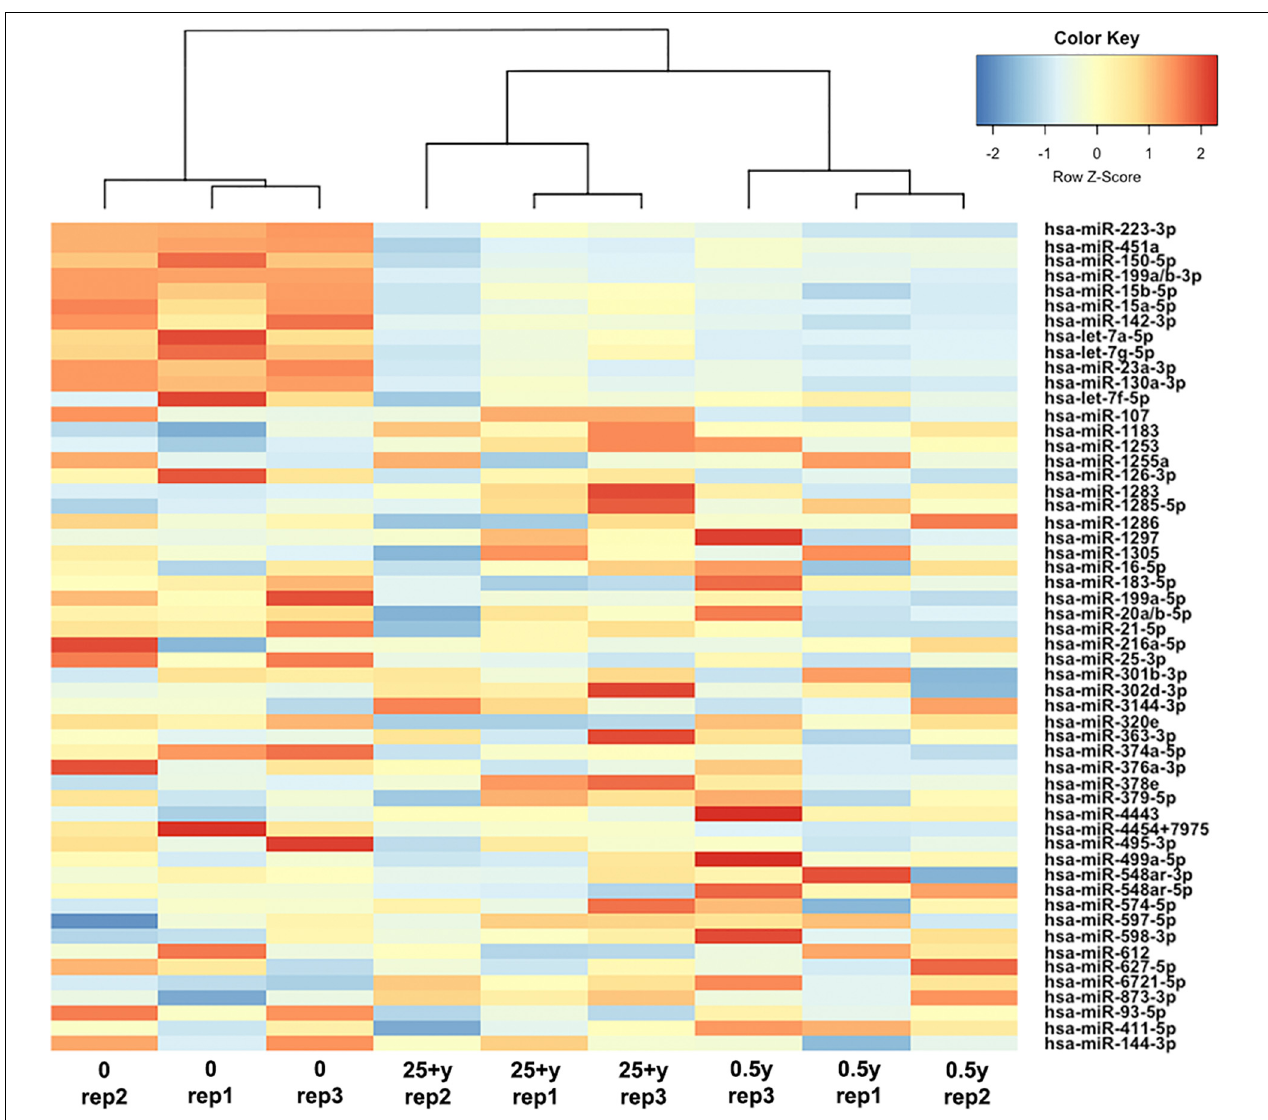
FIGURE 3 | Differential expression of circulating exomiRs. Heatmap with dendrogram shows clustering results for 54 exomiRs at baseline (0), after 0.5 year and 25 + years of regular exercise. Colors represent the level of exomiR expression; red: high expression; blue: low